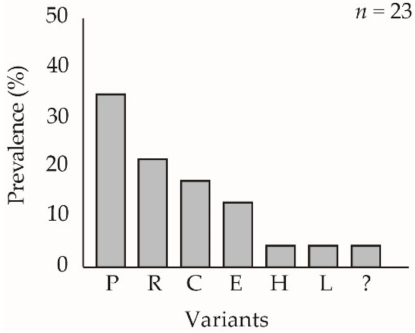
Figure 7. Prevalence of REN profiles from virus-killed Chrysodeixis includens fifth instars that died following injection of plaque picks derived from ChinNPV-K pure variant ODVs. New genotypes whose REN profiles did not match any of the previous studied variants were included in an unknown group shown as “?”; n indicates the number of plaque picks used to inoculate insects. The y -axis indicates the prevalence (%) of insects that produced progeny OBs with a particular dominant REN profile and the x -axis indicates each of the observed REN profiles in decreasing